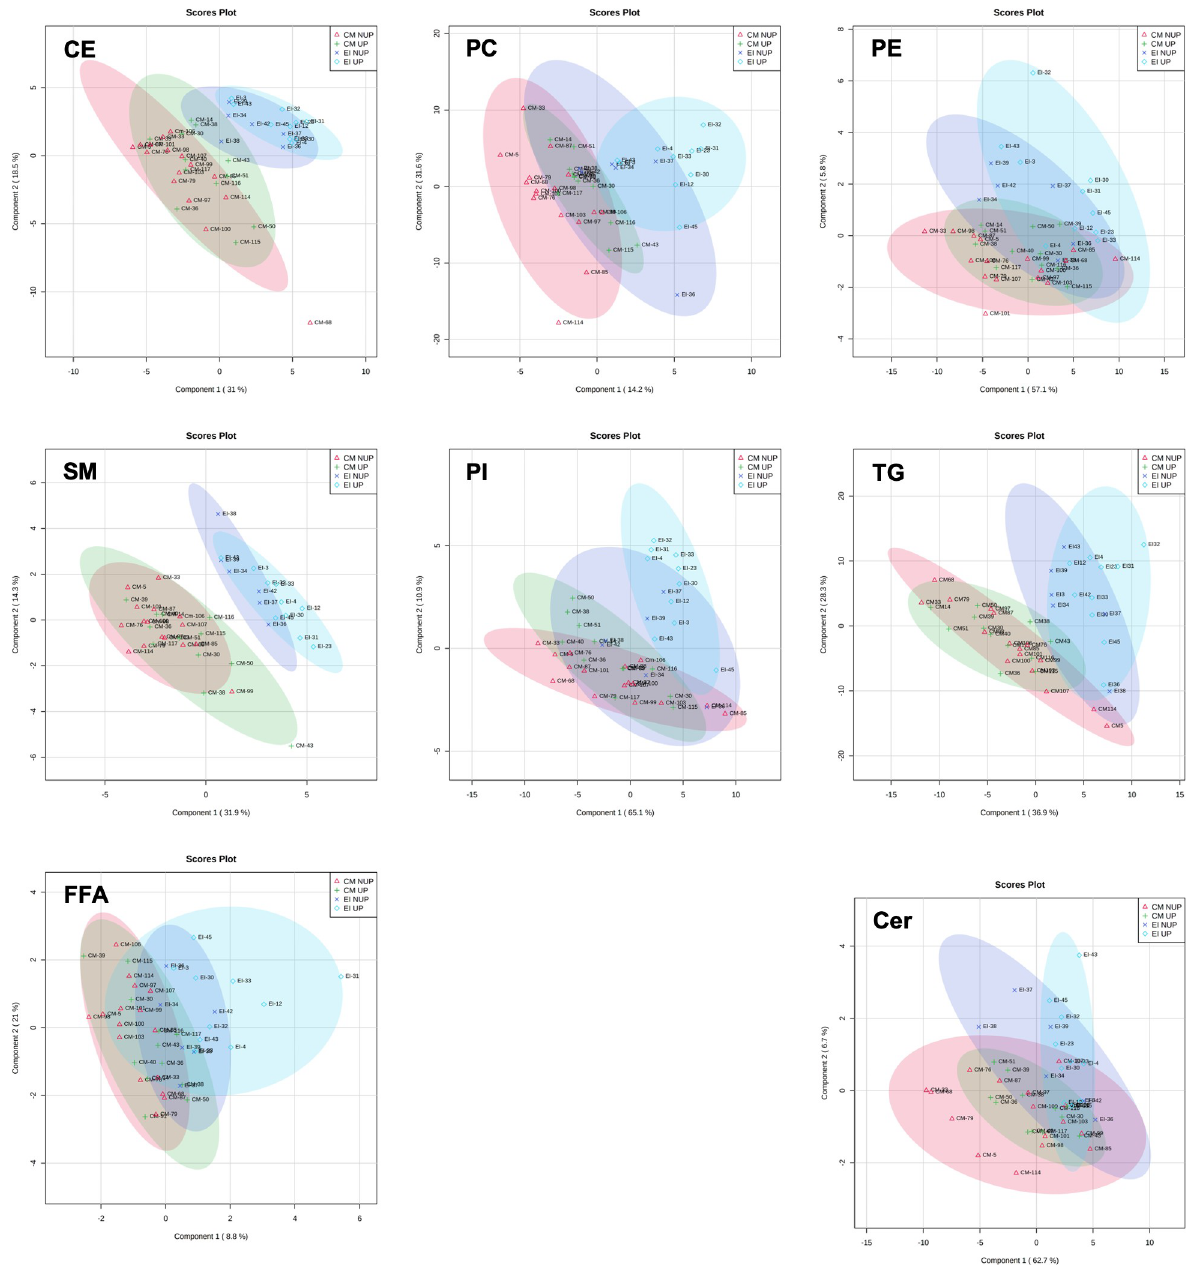
Fig 4. Partial least-squares discriminant analysis displaying seasonal clusters by plasma lipid profiles. Partial least-squares discriminant analysis (PLS-DA) component 1 (x-axis) and component 2 (y-axis) demonstrating species clusters as a result of plasma lipid profile in green turtles (CM) and hawksbill turtles (EI) and season (NUP = non-upwelling; UP = upwelling). We live captured all turtles in North Pacific Costa Rica in 2017. Abbreviations: CE = cholesteryl ester; PC = phosphatidylcholine; PE = phosphatidylethanolamine; SM = sphingomyelin; PI = phosphatidylinositol; TG = triacylglyceride; Cer = ceramide; FFA = free fatty acids; PG = phosphatidylglycerol; PS = phosphatidylserine; Car = acyl-carnitine.